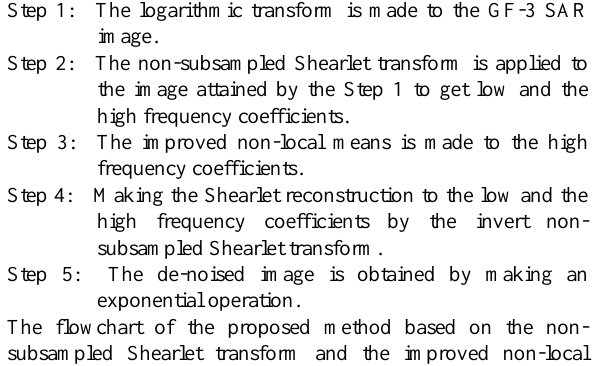
Fig 3. The flowchart of our